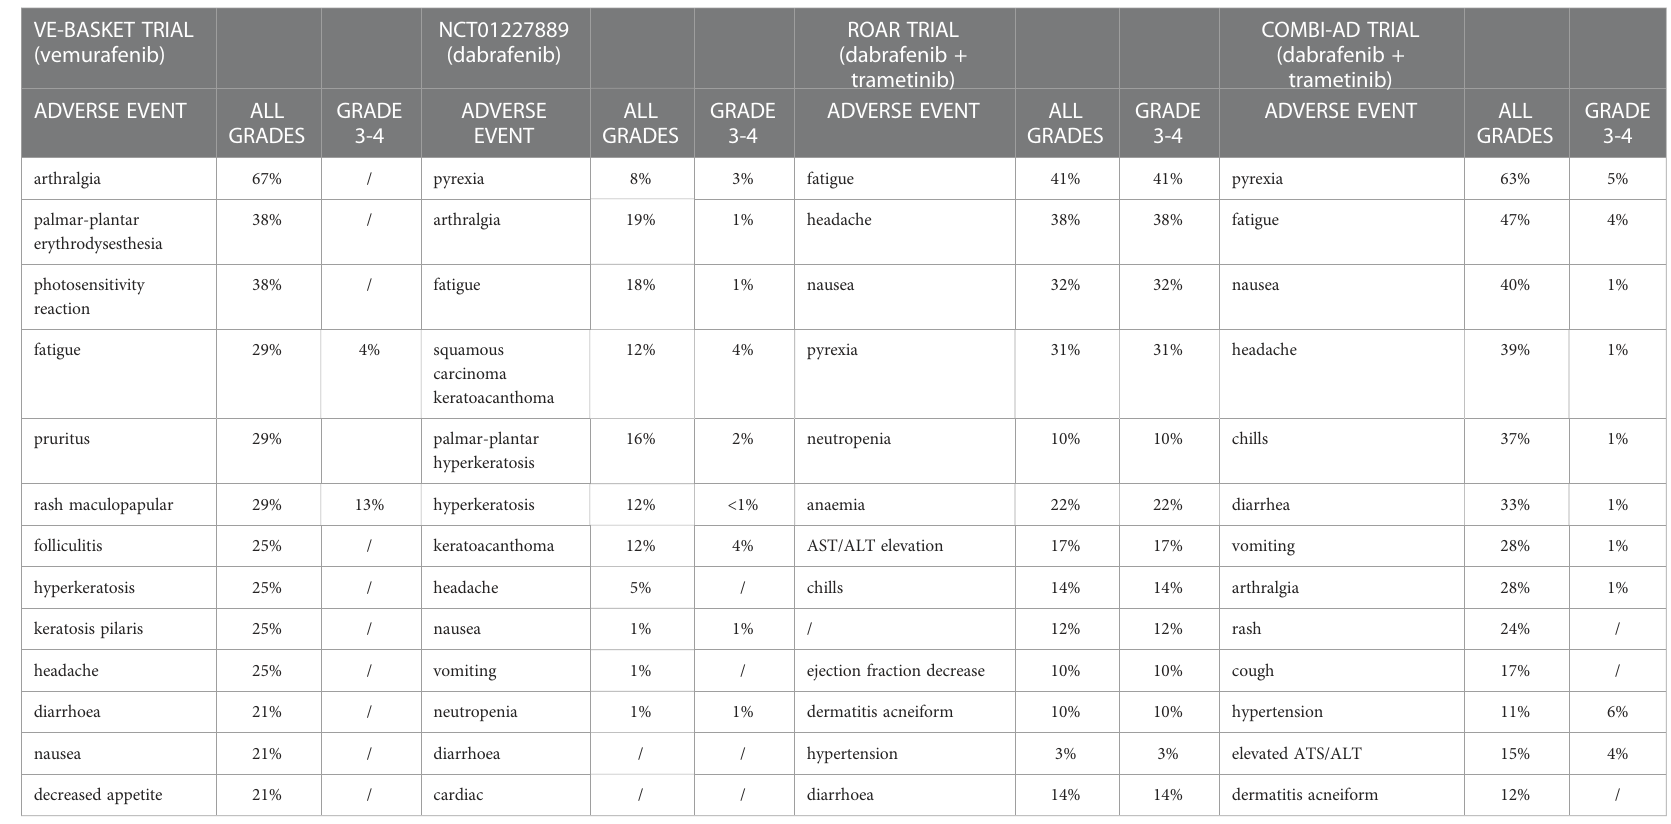
TABLE 3 Treatment adverse events reported in VE-BASKET, ROAR and COMBI-AD trial. VE-BASKET